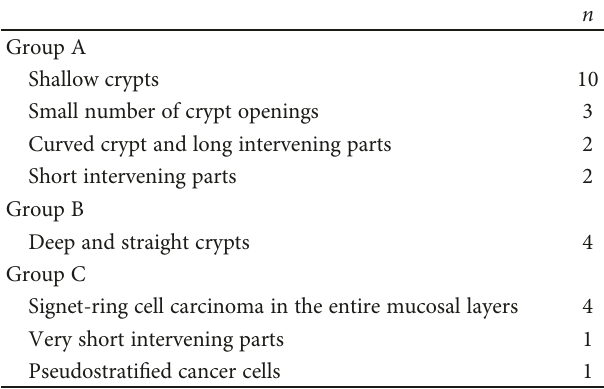
Table 2: Histological features of each group.